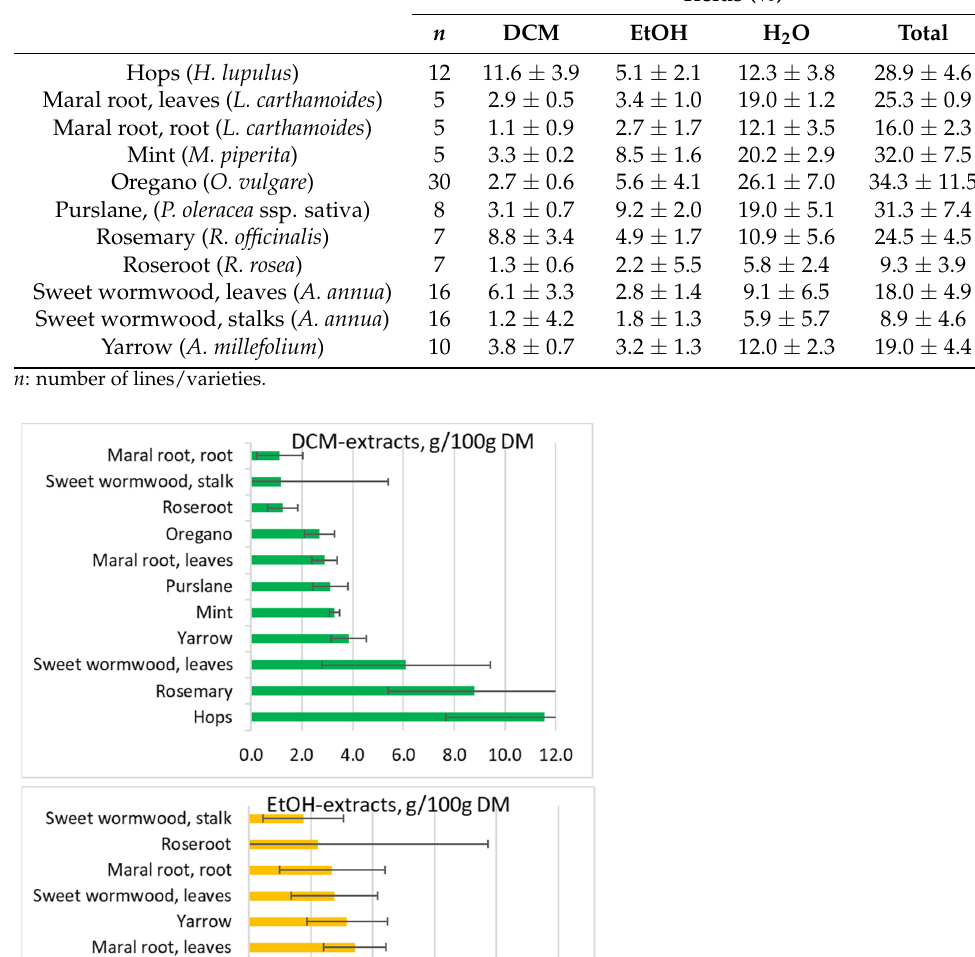
Table 1. The percentage extraction yields (mean ± SD) on a dry weight basis of nine herb. All extracts were made by ultrasound-assisted extraction (UAE). Extraction was performed in a sequential man- ner (DCM followed by EtOH and finally by H 2 O).